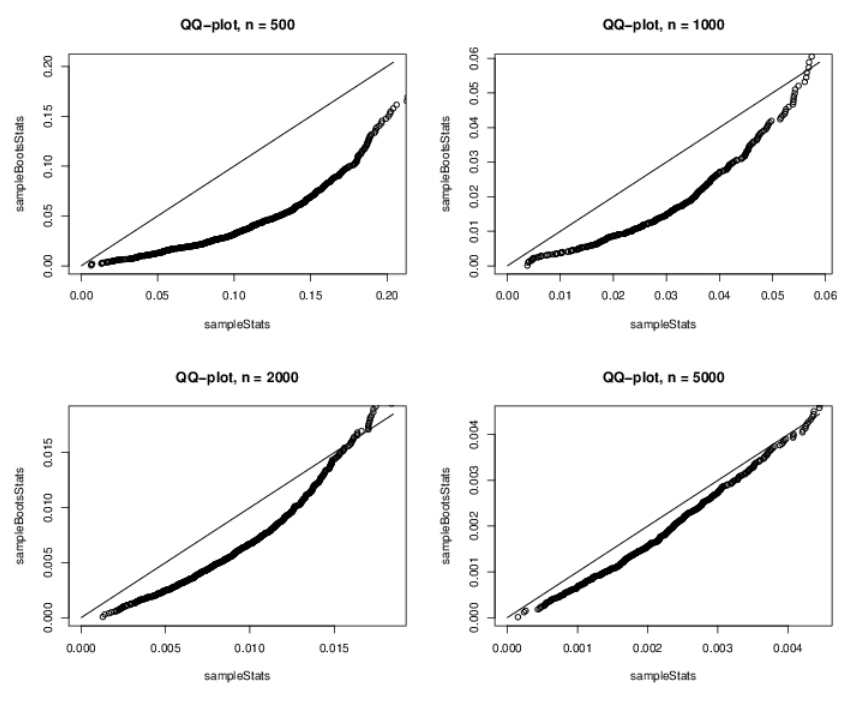
Figure 5: QQ-plot of a sample of the test statistic T c 2 and a sample of the bootstrap test statistic ( T c 2 ) * using the non-parametric bootstrap for the gaussian copula, with different sample sizes and under H c 0 (conditional Kendall’s tau is constant and equal to 0.5